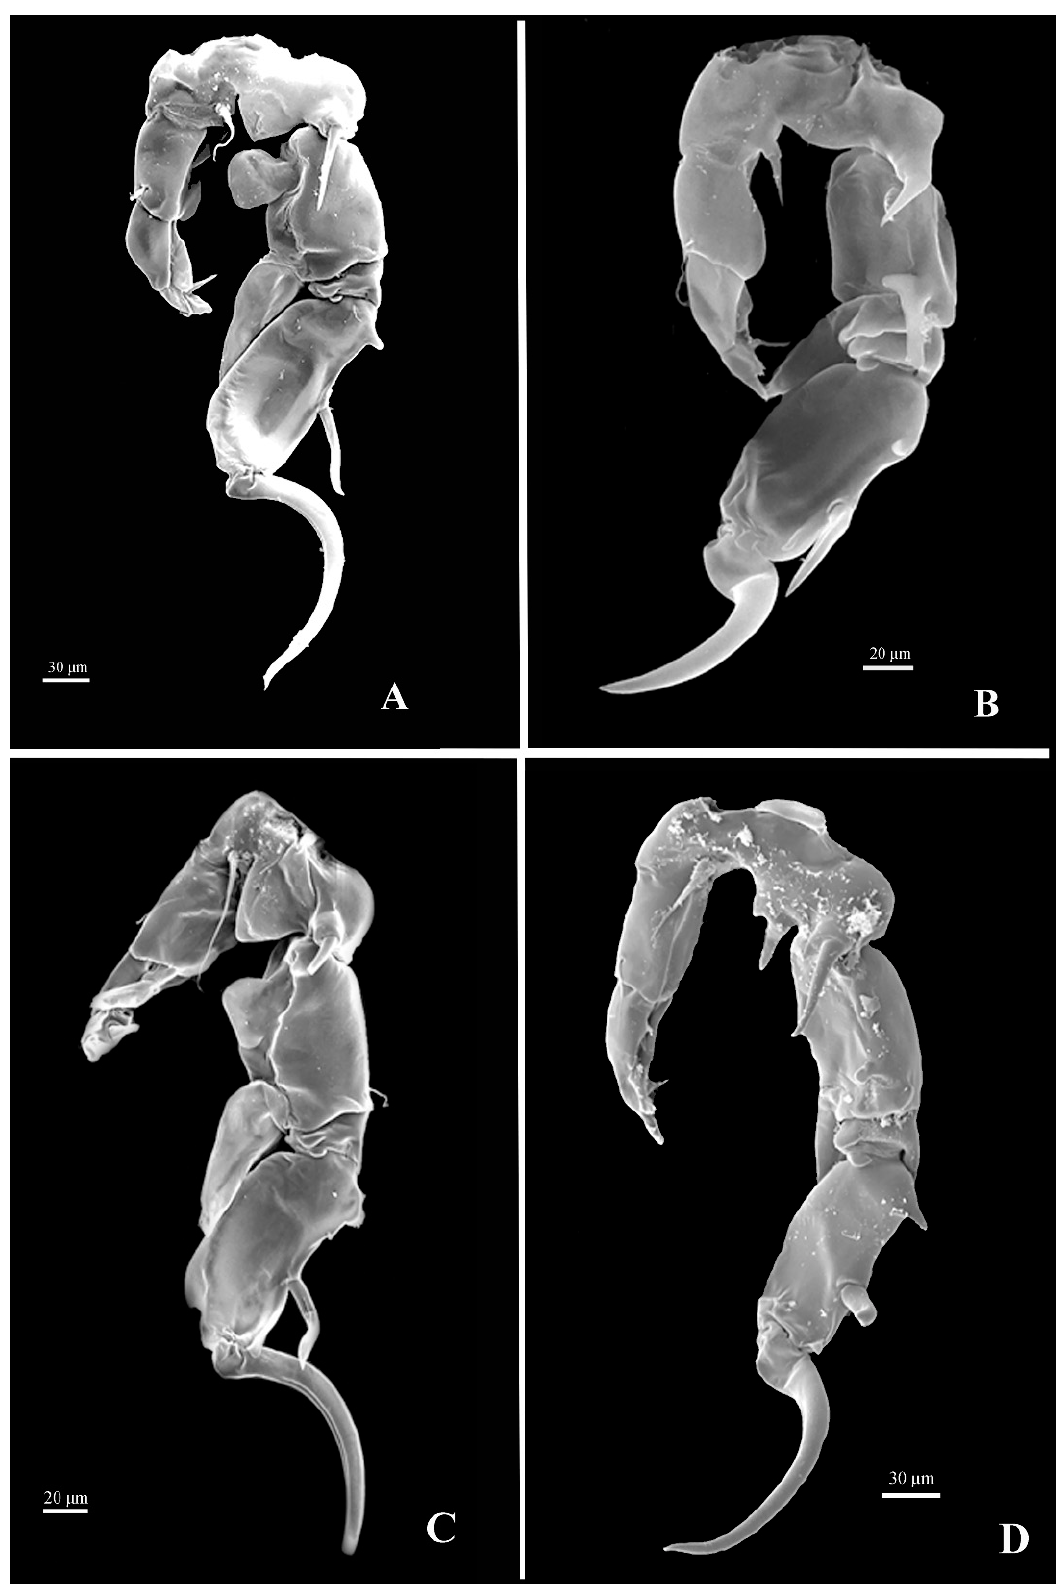
Figure 7. SEM photographs of the male leg 5 (P5) of four species of the genus Mongolodiaptomus : ( A ) M. botulifer ; ( B ) M. calcarus ; ( C ) M. malaindosinensis ; and ( D ) M. uenoi .